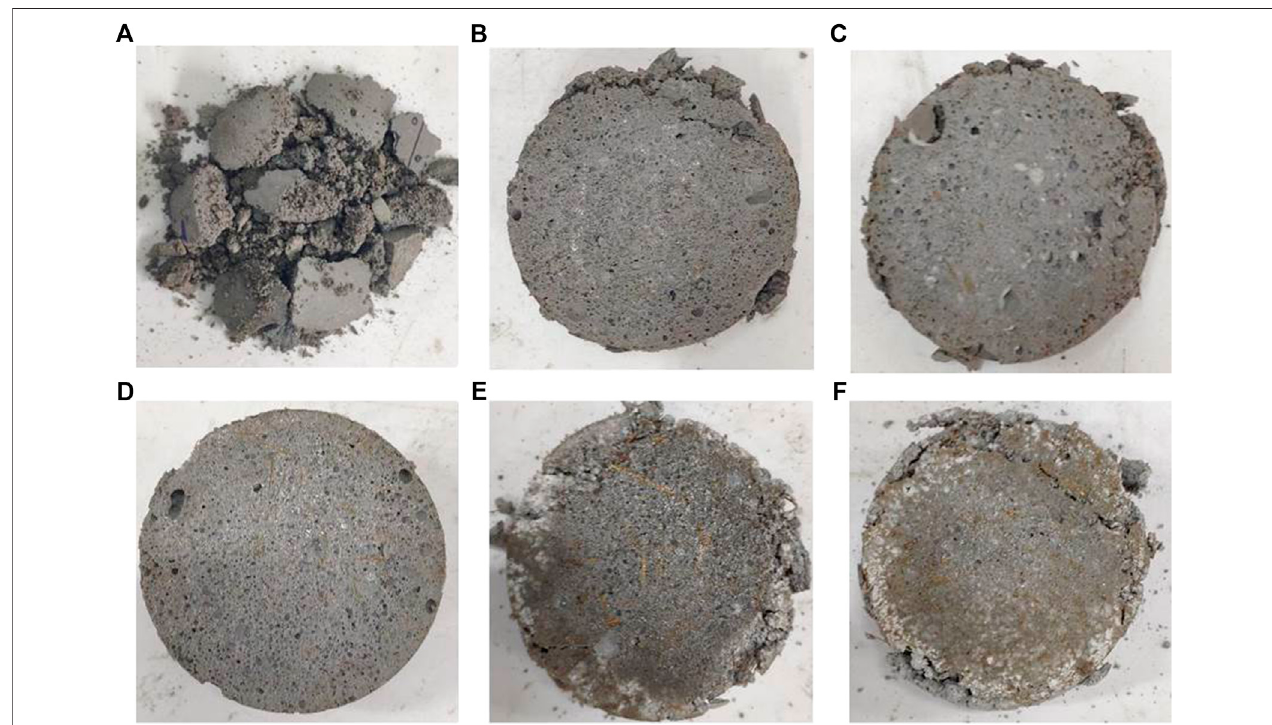
FIGURE4| Failure modes atthe gaspressureof0.2 MPa (A) CF0.0-AP0.20-1 (B) CF0.5-AP0.20-3 (C) CF1.0-AP0.20-1 (D) CF1.5-AP0.20-2 (E) CF2.0-AP0.20- 3 (F) CF2.5-AP0.20-3.